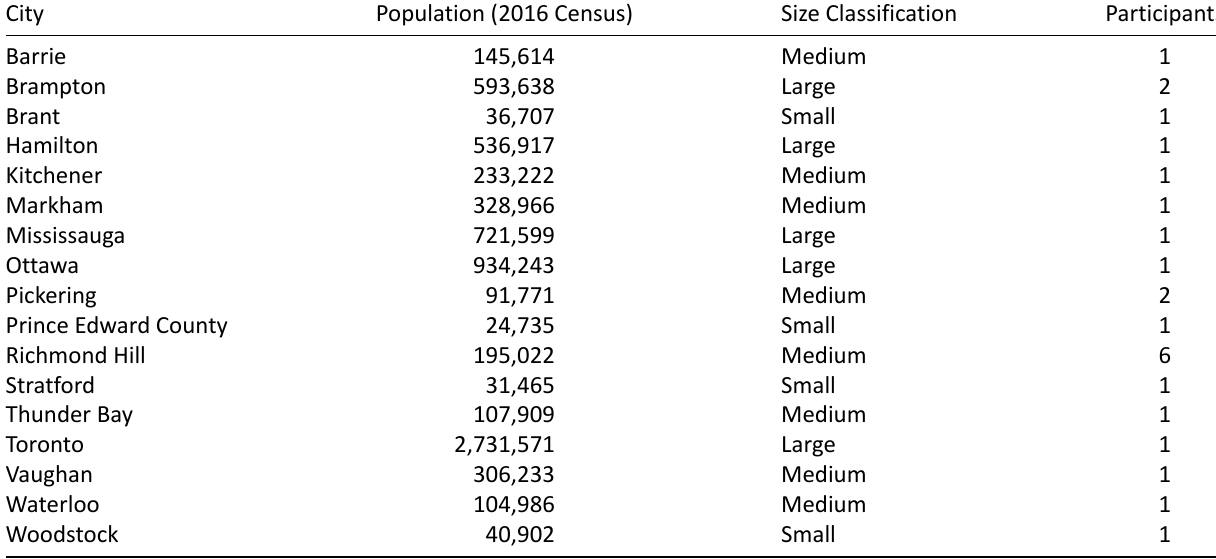
Table 1. Cities included in this